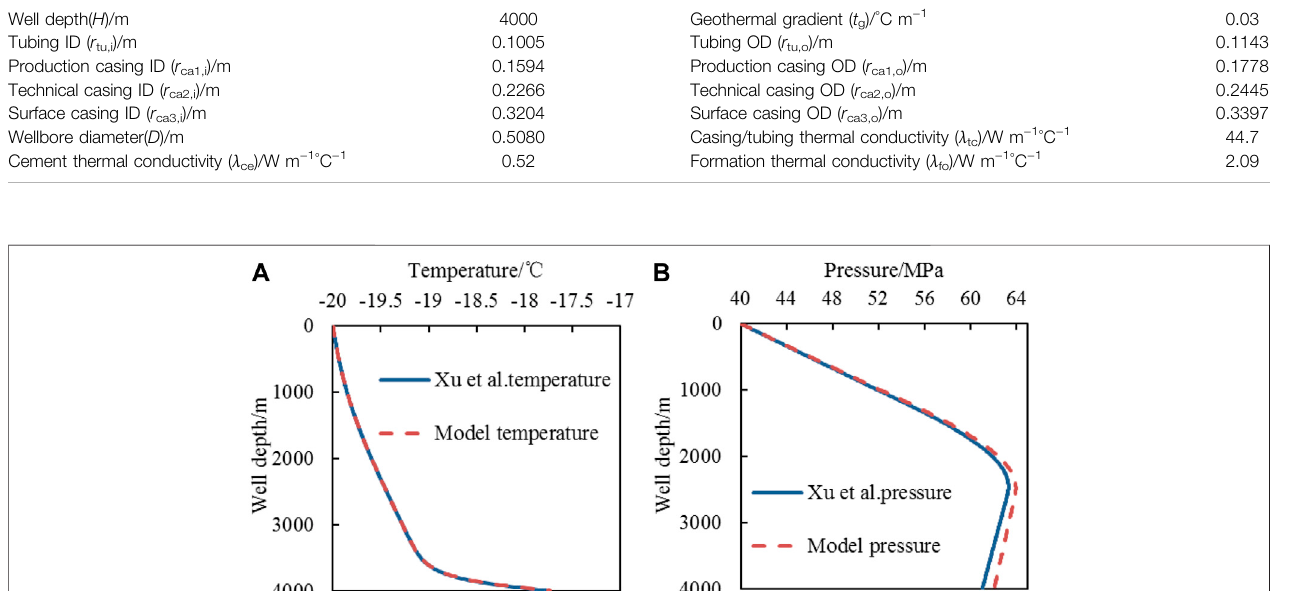
FIGURE 3 | Temperature and pressure distribution of CO 2 proppant gas-solid two phases in the wellbore [ (A) : temperature pro fi le; (B) : pressure pro fi le].